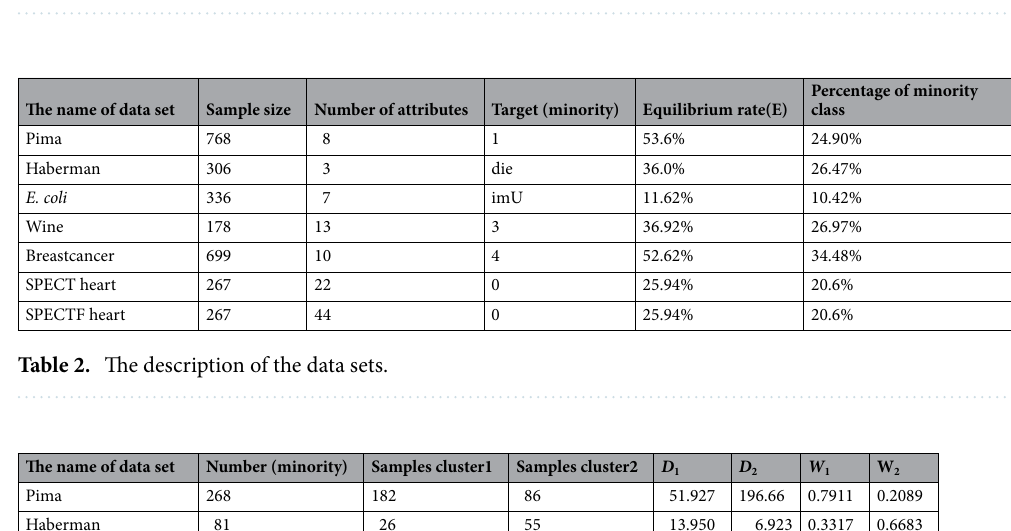
Table 1. Confusion matrix of binary classification problem.